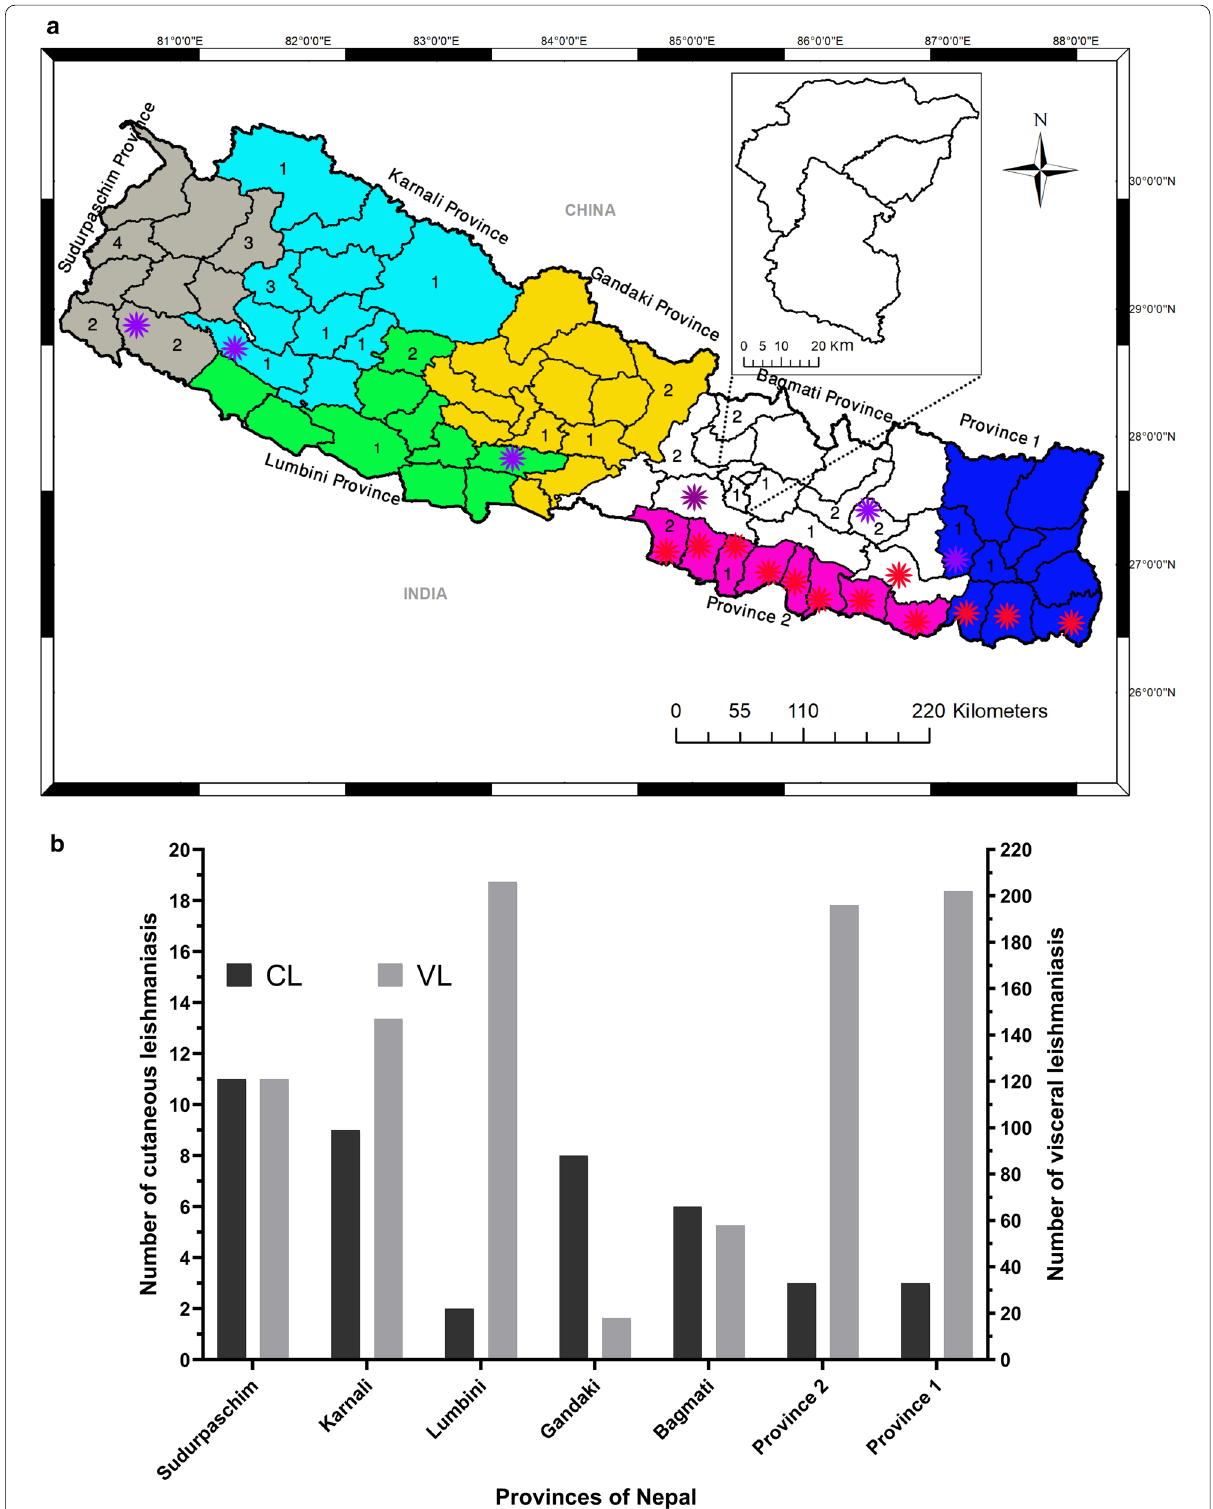
Fig. 4 Trend of leishmaniasis cases reported during 2016-2019 in Nepal. a Map of Nepal showing provinces of Nepal with different colors. Red and purple asterisks show 12 endemic and recently added 6 endemic districts for VL in Nepal. b The graph shows provincial breakdown of cutaneous leishmaniasis (CL) and visceral leishmaniasis (VL) cases in